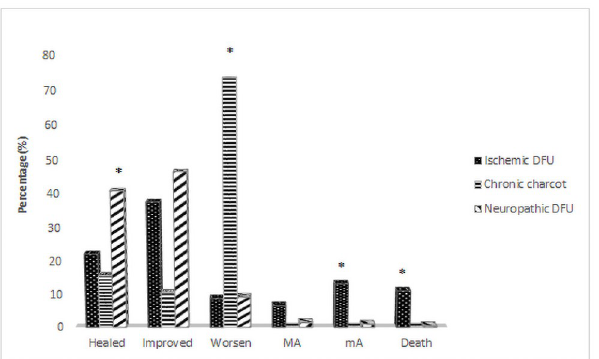
Fig 1. Ulcer and limb outcomes stratified by type of diabetic foot complications during COVID-19 pandemic. MA: Major amputation; mA: Minor Amputation; � p < 0.05 and significant.